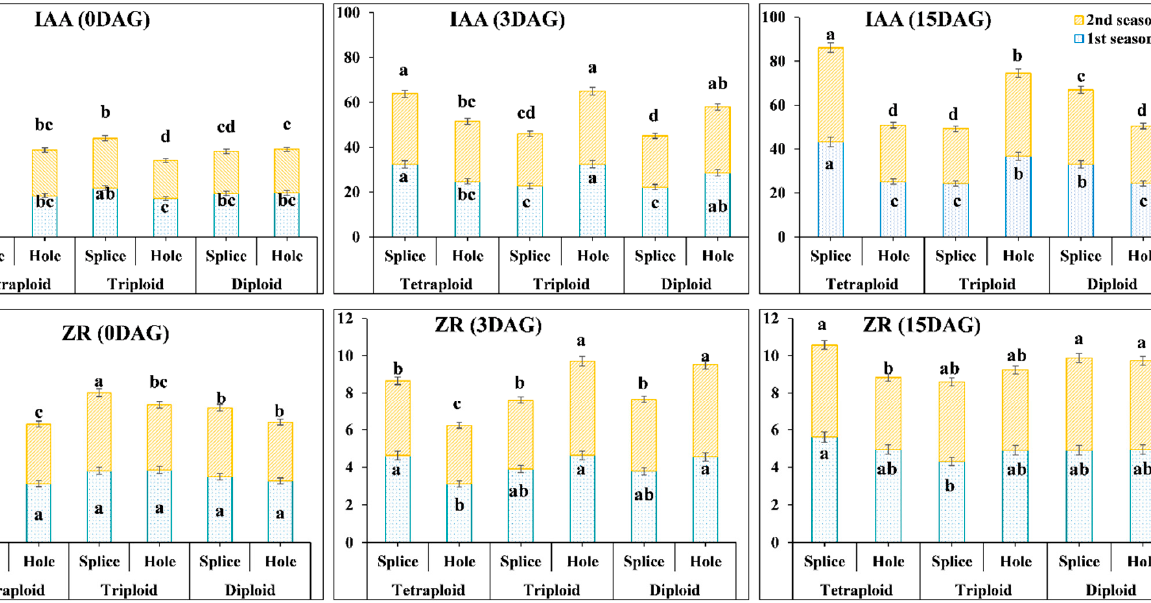
Figure 3. IAA and ZR hormones contents in different ploidy watermelon grafted with splice and hole methods at 0, 3, and 15 DAG, during March and August 2019 cropping seasons grafted with splice and hole methods. The bars with different letters differ significantly ( p < 0.05). IAA: Indole acetic acid, ZR: Zeatin Riboside, DAG: Days after grafting.